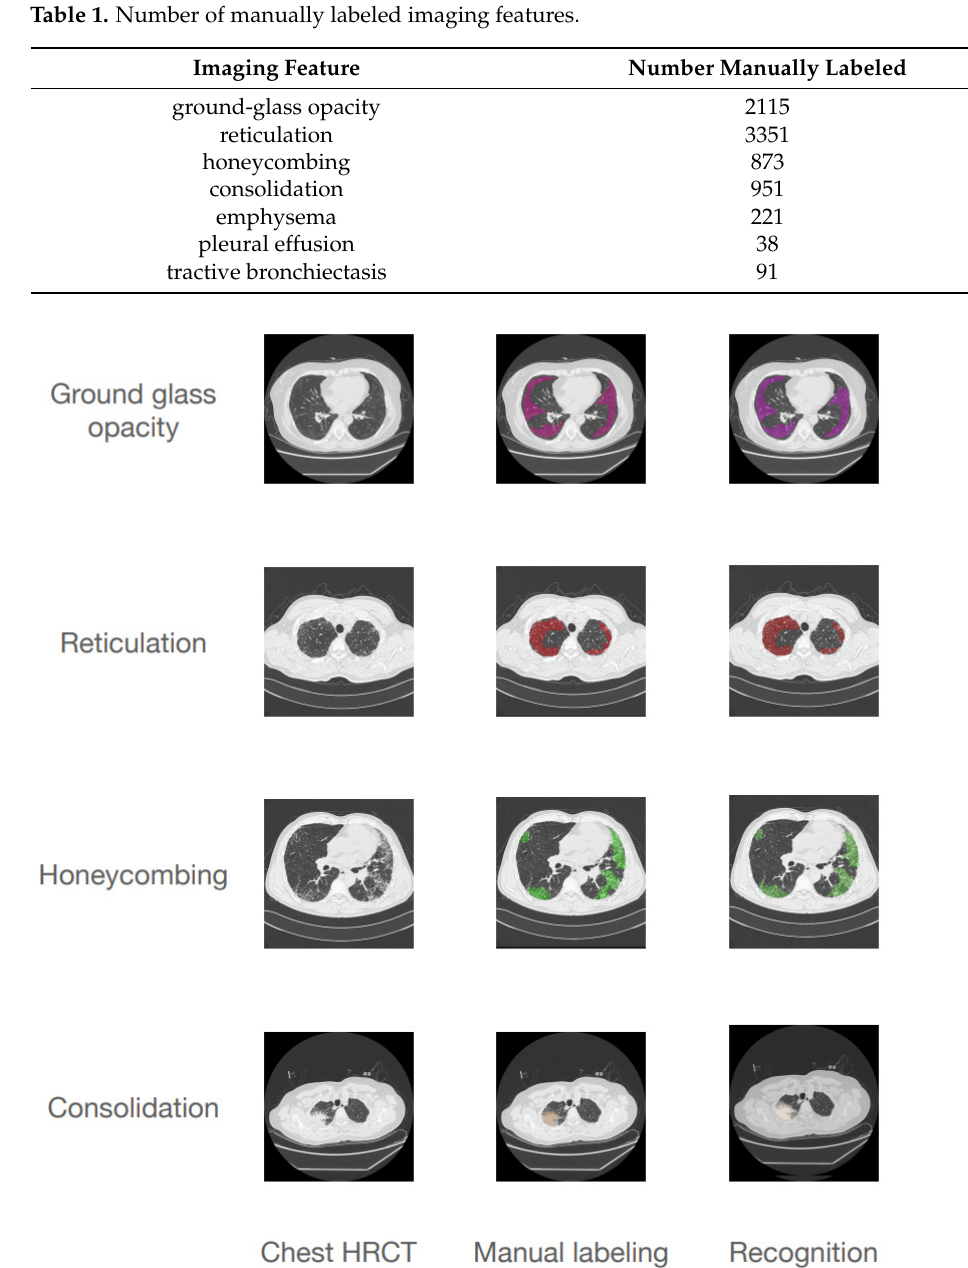
Figure 3. Results of the U-net model in identifying four imaging features in IIP patients. HRCT, high-resolution computed tomography. Chest HRCT line shows the four imaging features in HRCT. Manual labeling line shows the four imaging features labeled by radiologists. Recognition line shows the four imaging features recognized using the U-net model.